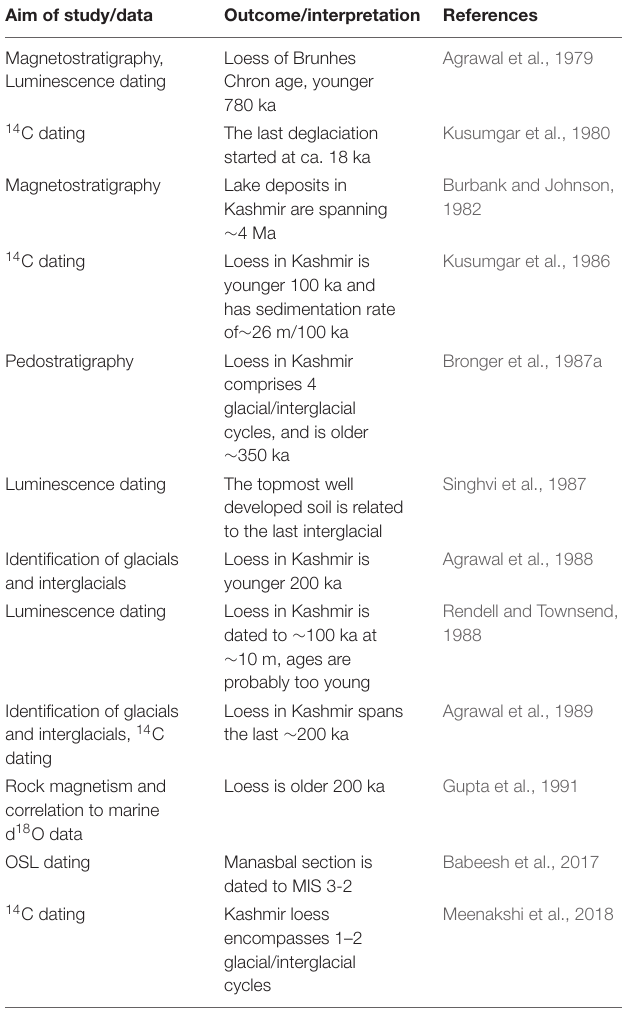
TABLE 1 | Stratigraphic data and ideas as in literature, ordered by